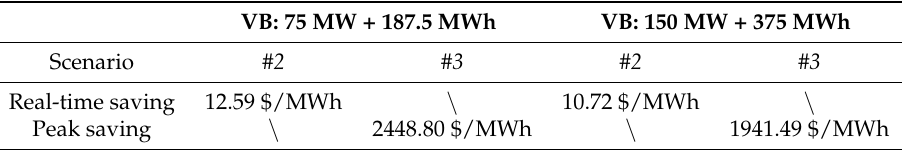
Table 2. Per-unit savings for VB capacity and power